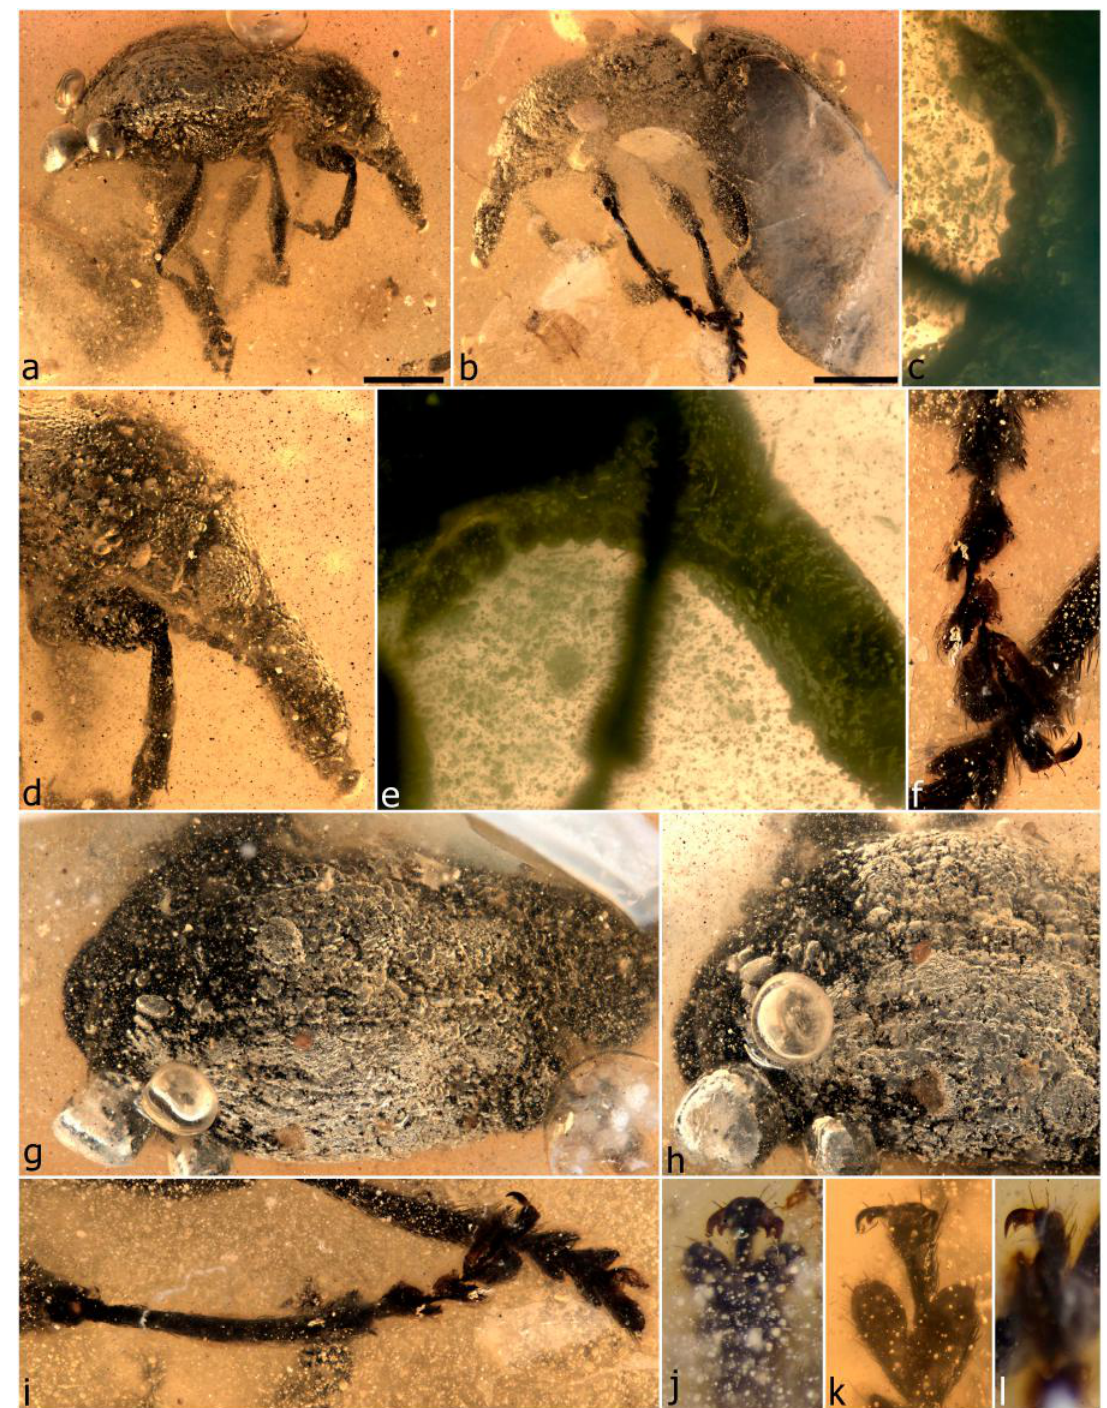
Figure 22. Calyptocis brevirostris sp. n., holotype. Habitus, right lateral ( a ); habitus, left lateral ( b ); detail of antenna, right lateral ( c ); head and prothorax, right lateral ( d ); rostrum and antenna, right lateral ( e ); protarsus ( f ); elytra, dorsal ( g ); elytra and pygidium, dorsoposterior ( h ); forelegs ( i ); claw ( j–l ). Scale bars: 1.0 mm (a,b).